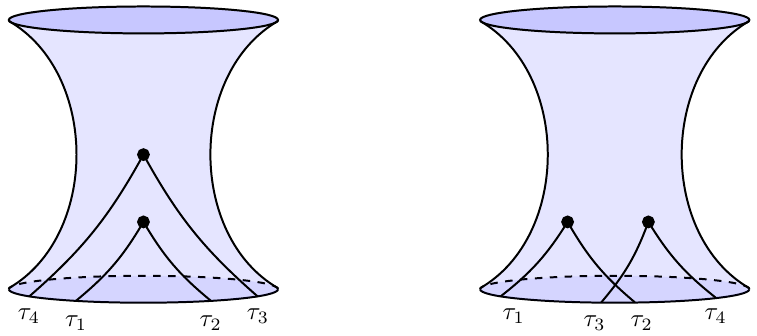
Figure 9 . The four-point function in the Schwarzian theory corresponds to a two-point function of two bulk Liouville vertex operators. If the two bulk operators are timelike separated (left), the correlation function and the end-points of the two bi-local operators are time ordered. If the two bulk operators are spacelike separated (right), the legs of the bi-local operators (which follow 2D light-cone directions starting from each vertex) cross each other. Time-ordered and out-of-time ordered correlation functions are thus related by the CFT monodromy matrix that relates the timelike separated and spacelike separated two-point functions.